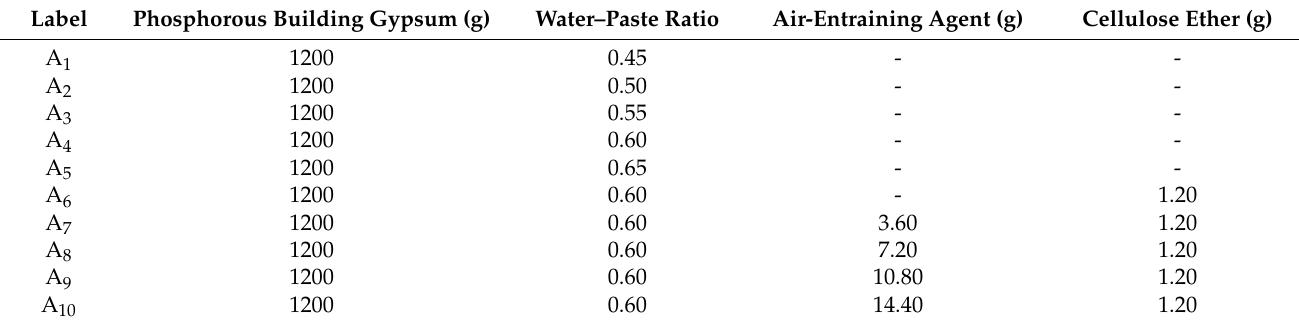
Table 2. Mixture ratio of phosphorus building gypsum.